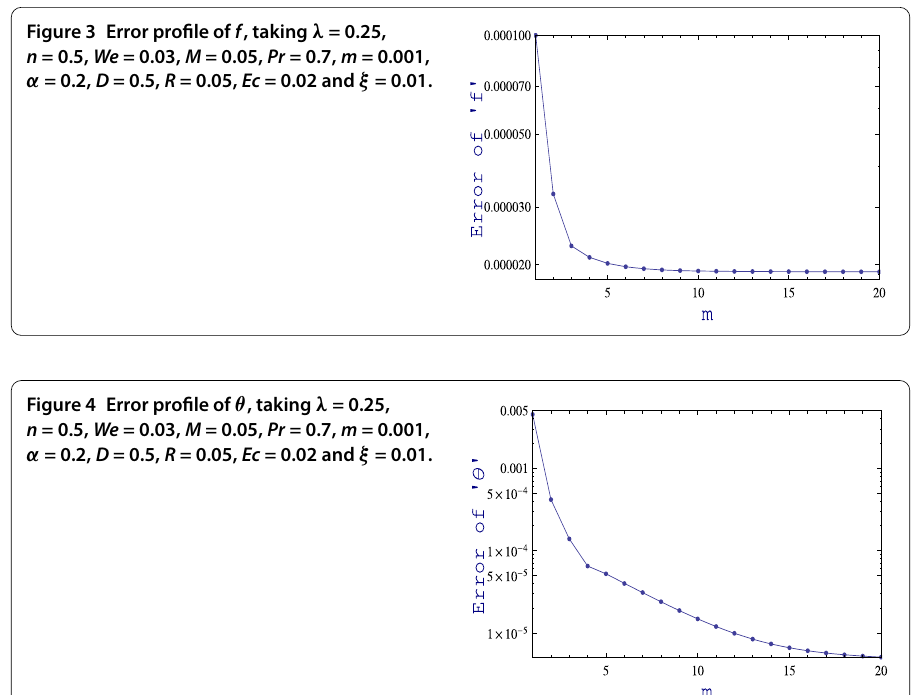
Figure 3 Error profile of f , taking λ = 0.25, n = 0.5, We = 0.03, M = 0.05, Pr = 0.7, m = 0.001,